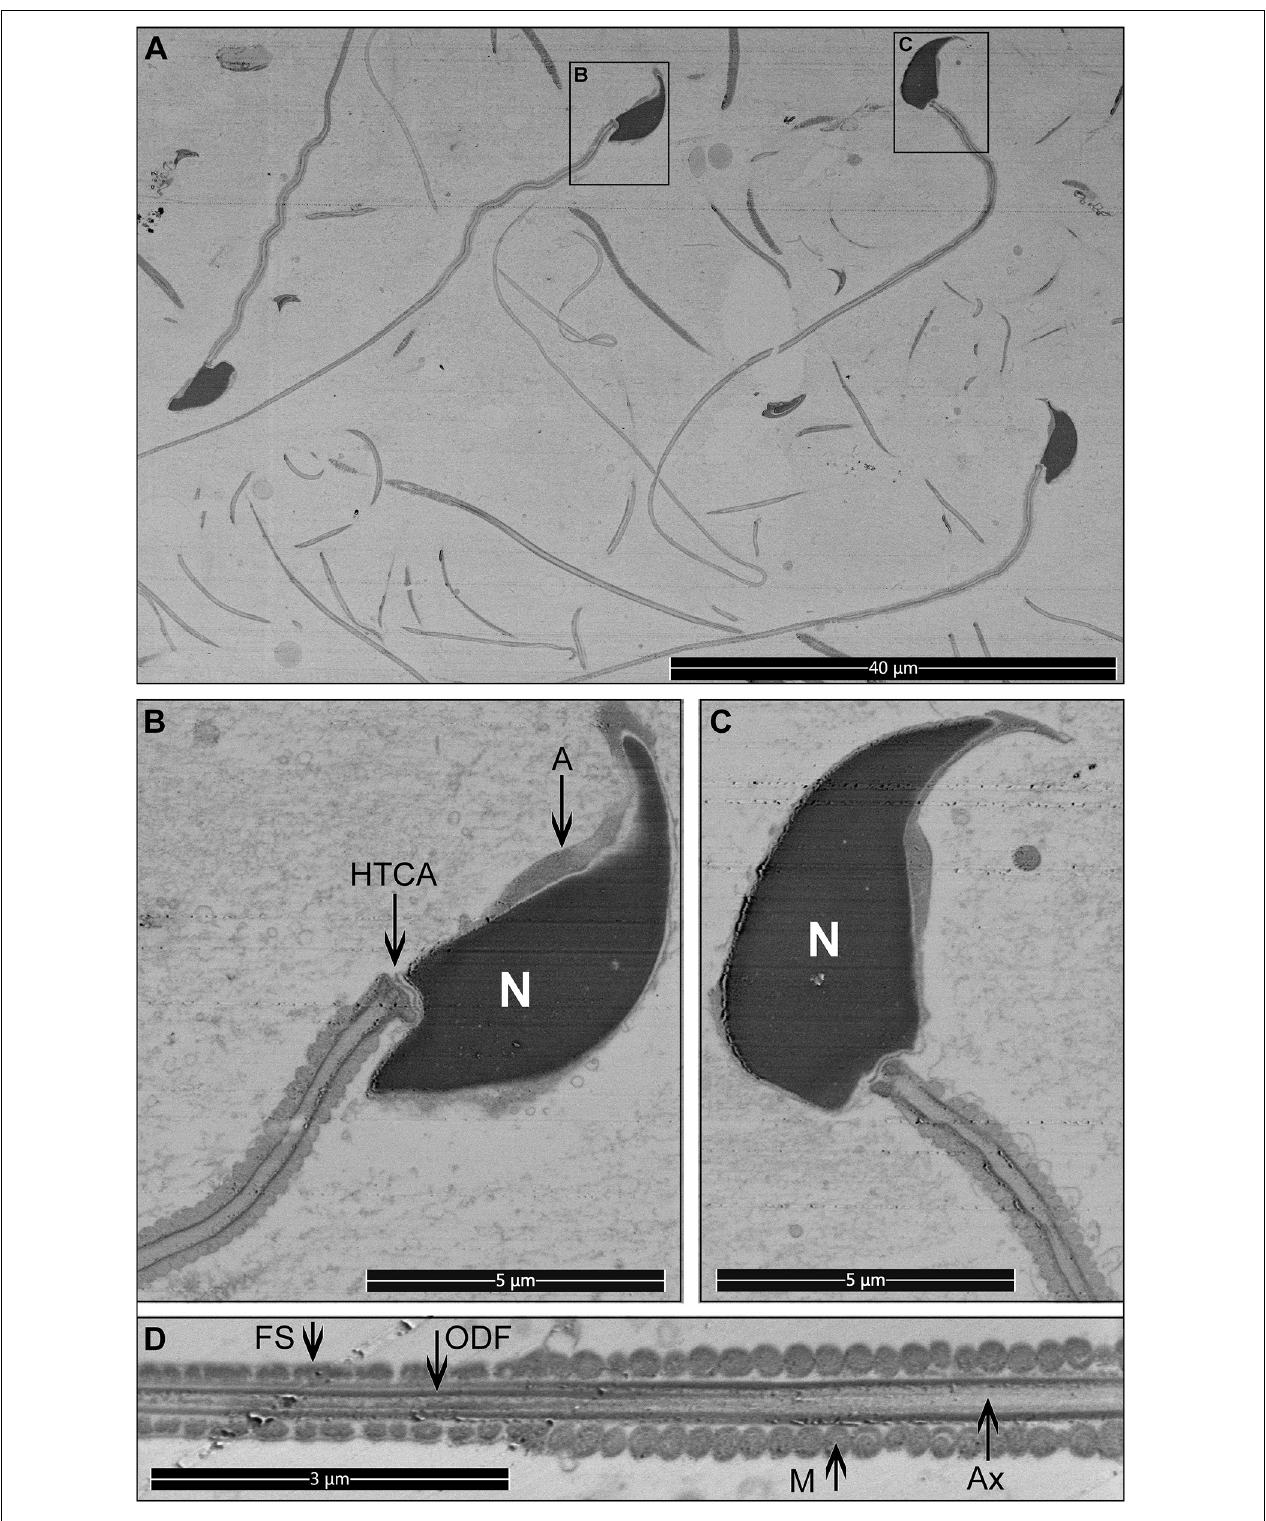
FIGURE 6 | Longitudinal sections for mouse sperm. Pictures were collected from the top surface of a pre-trimmed block in backscatter mode. (A) Low magnification, multiple cross-sections of different sperm are visible. Scale bar 40 µ m. (B–D) The internal structure of sperm cells. Scale bar 5 µ m. M, mitochondria in the mid-piece; FS, fibrous sheath in the principal piece; ODF, outer dense fibers; Ax, microtubules of the axoneme; A, acrosome; N, highly condensed DNA within the nucleus; HTCA, head-tail-coupling apparatus.